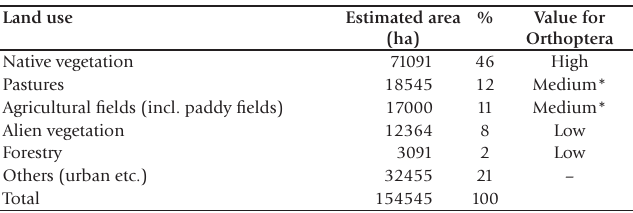
Table 1. Area of land use and vegetation types in Japanese riparian areas (after Miyawaki and Washitani 2004).